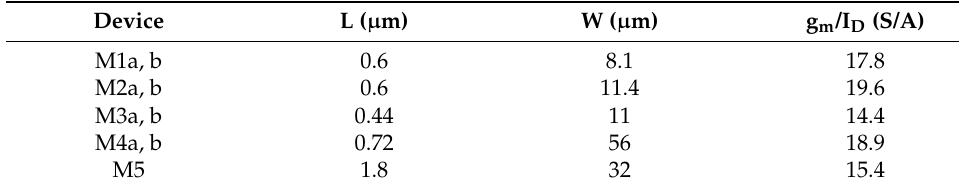
Figure 4. Design space of the predicted topology. Table 5. Sizing parameters of the example design point.